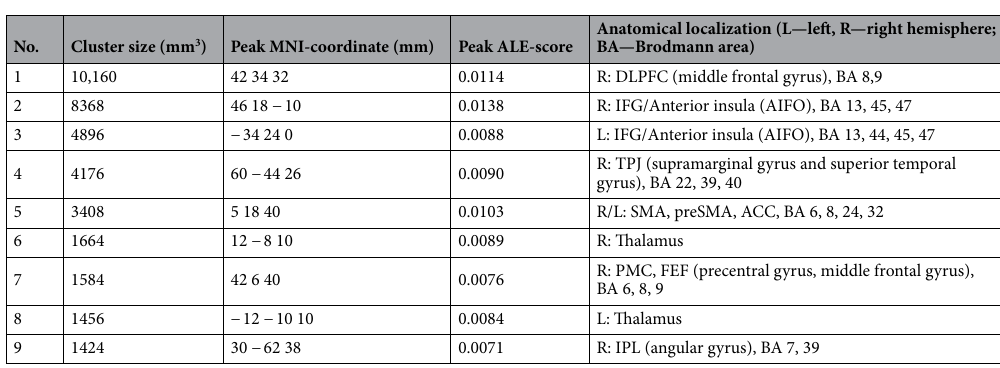
Table 1. The result of the ALE meta-analysis of 20 fMRI studies using equal probability Go/NoGo tasks (“50/50% Go/NoGo blocks > 100% Go-control blocks” contrast). DLPFC dorsolateral prefrontal cortex, IFG inferior frontal gyrus, AIFO anterior insula/frontal operculum, TPJ temporoparietal junction, SMA supplementary motor area, ACC anterior cingulate cortex, PMC premotor cortex, FEF frontal eye field, IPL inferior parietal lobule.